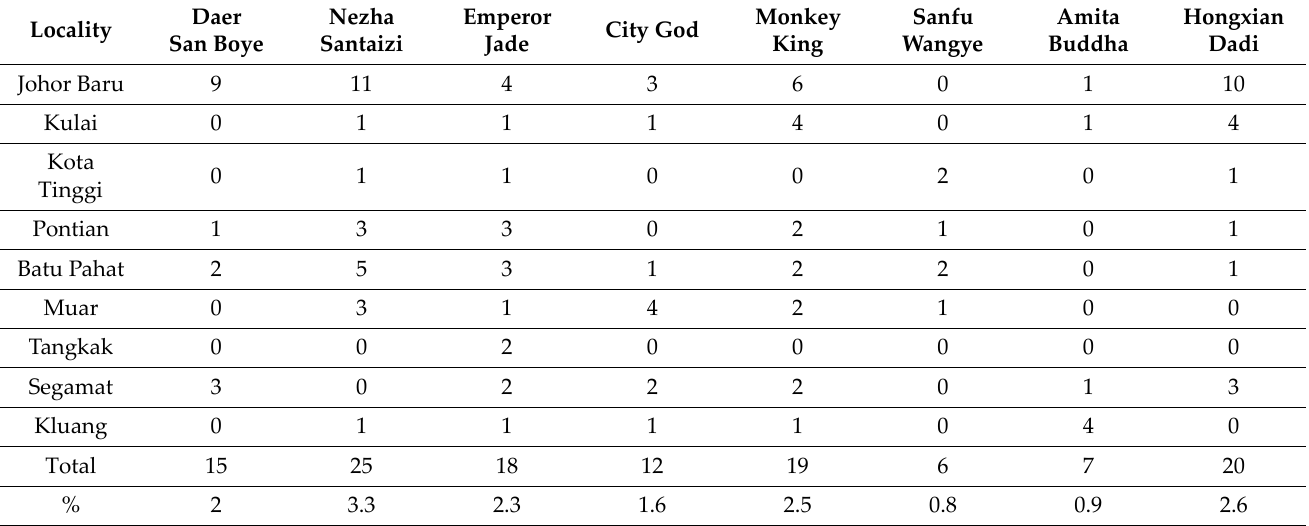
Table 13. Main Deity and Their Distribution in Each District (2.0).